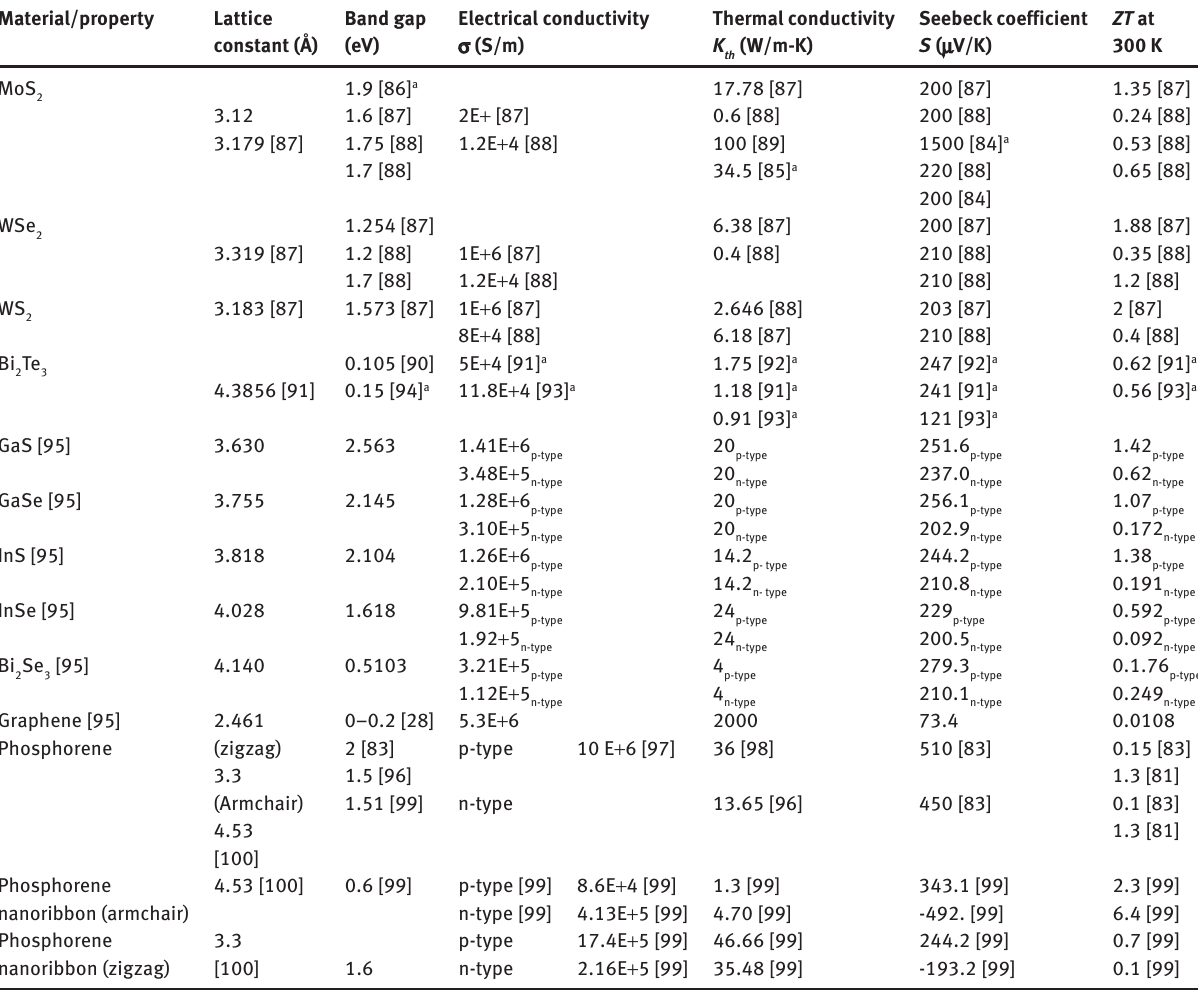
Table 1: Thermoelectric properties of several 2D materials.